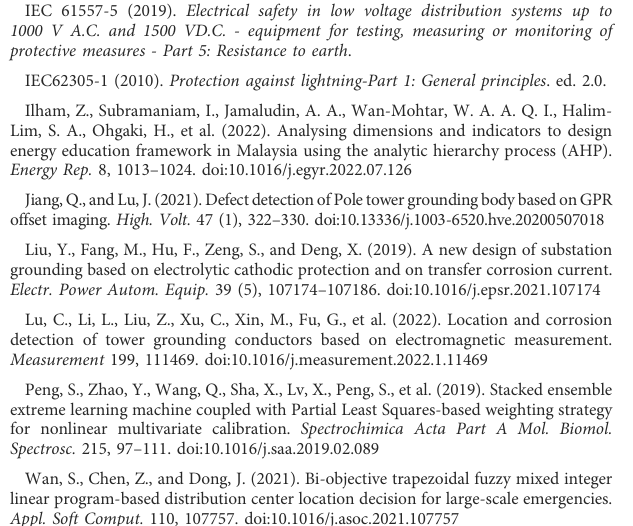
IEC 60364-5-54 (2011). Low-voltage electrical installations-Part 5-54: Selection and erection of electrical equipment – Earthing arrangements and protective conductors . IEC 61557-5 (2019). Electrical safety in low voltage distribution systems up to 1000 V A.C. and 1500 VD.C. - equipment for testing, measuring or monitoring of protective measures - Part 5: Resistance to earth